Question: Write a descriptive caption for this figure.
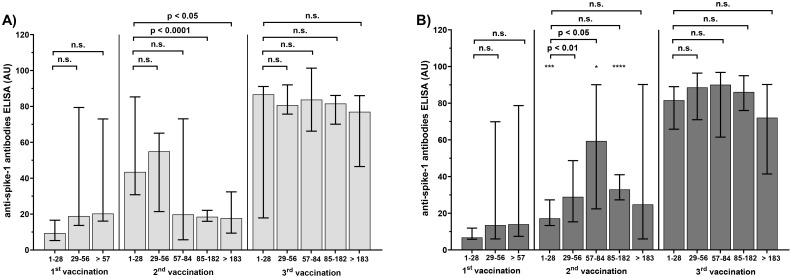
Answer: Correlation between time after vaccinations (in days) and IgG-anti-spike-1 antibody production in healthy individuals (A) and in patients with hematological disorders after HCT (B) in relation to the number of vaccinations. Significant as compared to antibody reactivity in healthy individuals after the same time of vaccination *p < 0.05; ***p < 0.001; ****p < 0.0001; After first and third vaccination, there were no significant differences between patients and healthy individuals. AU: arbitrary units; n.s.: not significant. Median ± 95% CI is given.